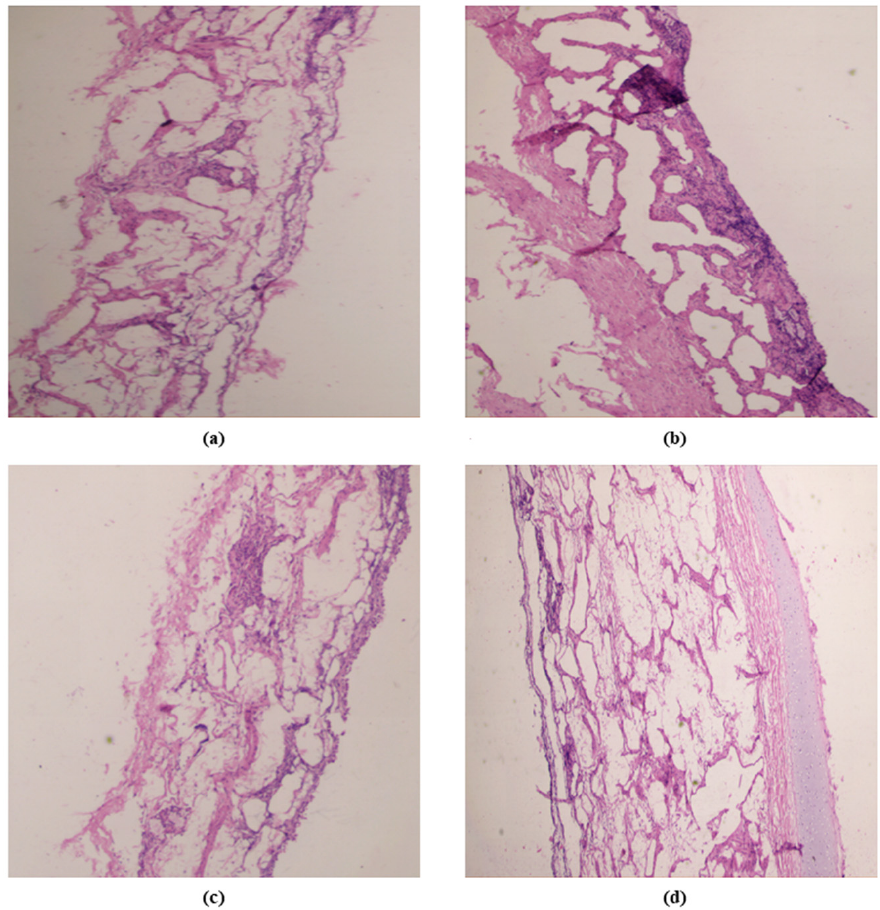
Figure 7. Histopathological optical micrograph structure of goat nasal mucosa treated with ( a ) nasal saline buffer pH 6.4, ( b ) isopropyl alcohol, ( c ) PIP suspension, and ( d ) PIP-SPL formulation (20× magnification).